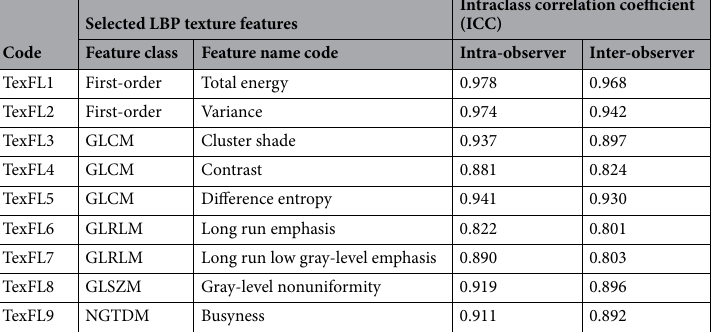
Table 2. Selected LBP texture features for machine learning–based classifications of IIM and non-IIM disease groups. LBP local binary pattern, GLCM gray-level co-occurrence matrix, GLRLM gray-level run length matrix, GLSZM gray-level size zone matrix, NGTDM neighboring gray-tone difference matrix.